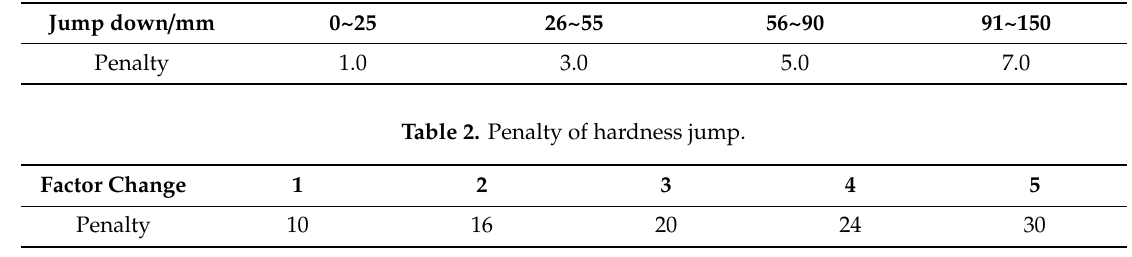
Table 1. Penalty of width jump.